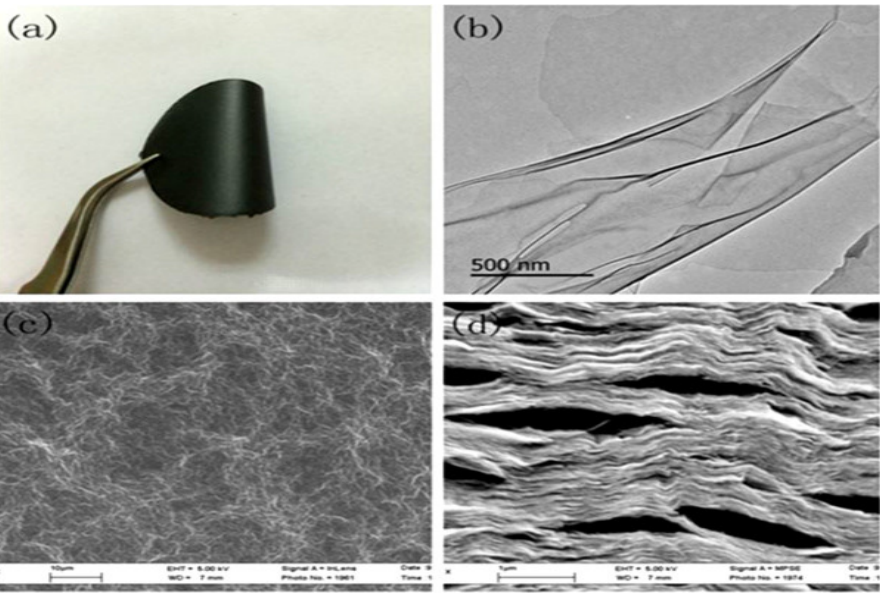
Figure 19. ( a ) Photograph of the GO membrane: ( b ) TEM image of GO. ( c ) SEM image of the surface of the GO membrane. ( d ) SEM image of the cross-section of the GO membrane. Reproduced with permission from [185], copyright of Elsevier.